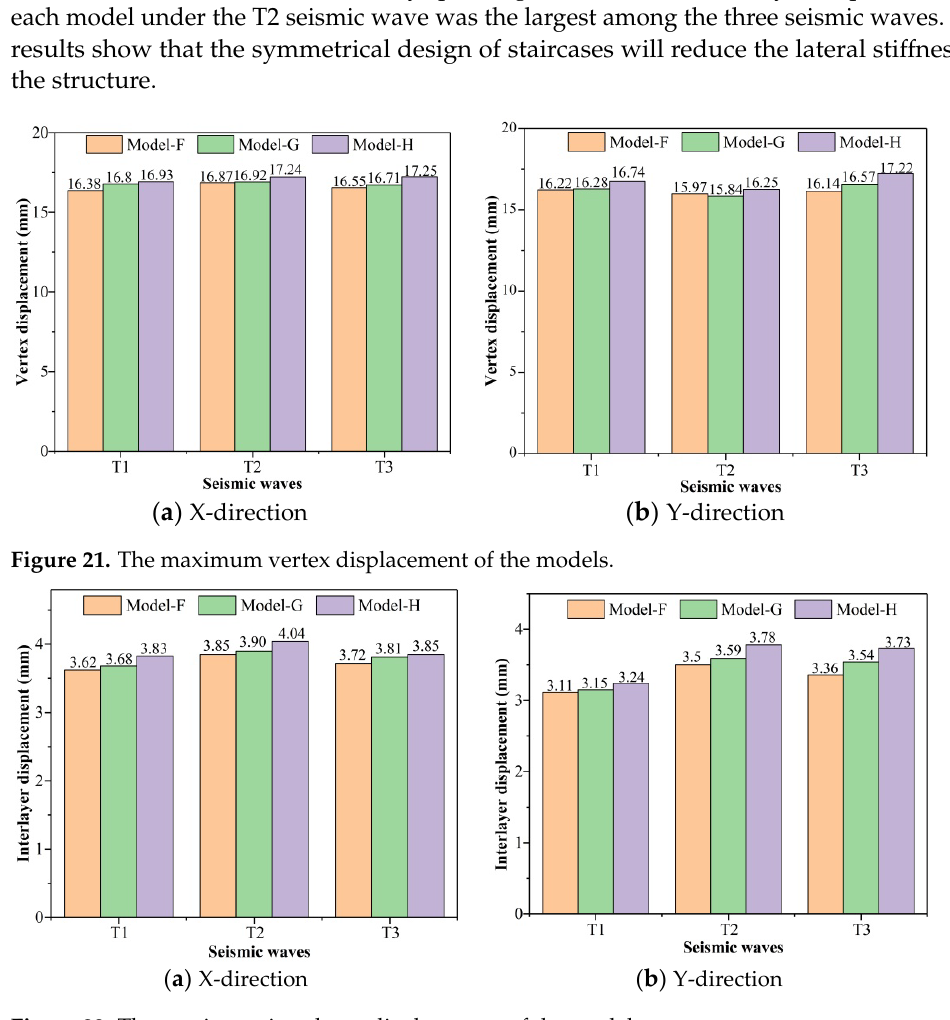
Figure 22. The maximum interlayer displacement of the models.